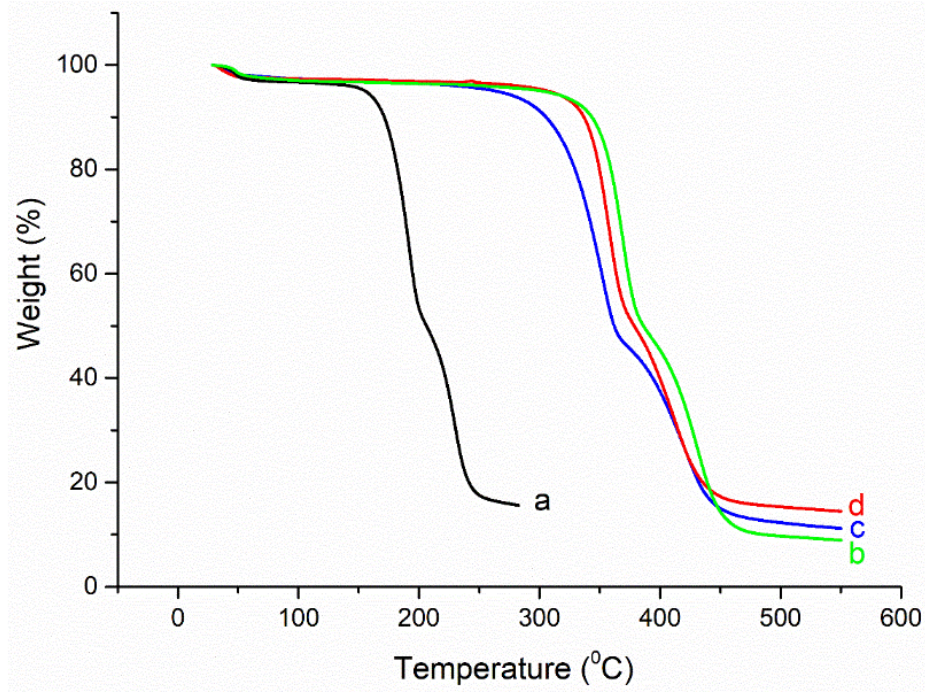
Figure 6. TGA thermograph of untreated cotton fabrics (a); CSNPs treated cotton fabrics (b); Acid Blue 317 dyed CSNPs treated cotton fabrics (c); Acid Red 88 dyed CSNPs treated cotton fabrics (d). SEM microscopy was used to analyze the surface morphology of treated and coloured cotton fabrics (SEM). Figure 6 illustrates the alteration in the morphology of cotton fibres following treatment with chitosan nanoparticles (CSNPs) and dyeing with two acid colours. Cotton fabrics that have not been treated exhibit a smooth surface (Figure 7a). The smooth surface is embedded with amazing nanoparticles derived from CSNPs on both the inside and outside of the fibre surface (Figure 7b). Cotton fabrics dyed with two acid dyes exhibit coated and granulated CSNPs (Figure 7c,d). Thus, SEM imaging confirms the presence of CSNPs both within and outside cotton fabrics, both completed and finish dyed, as well as the coating process for coloured cotton samples.